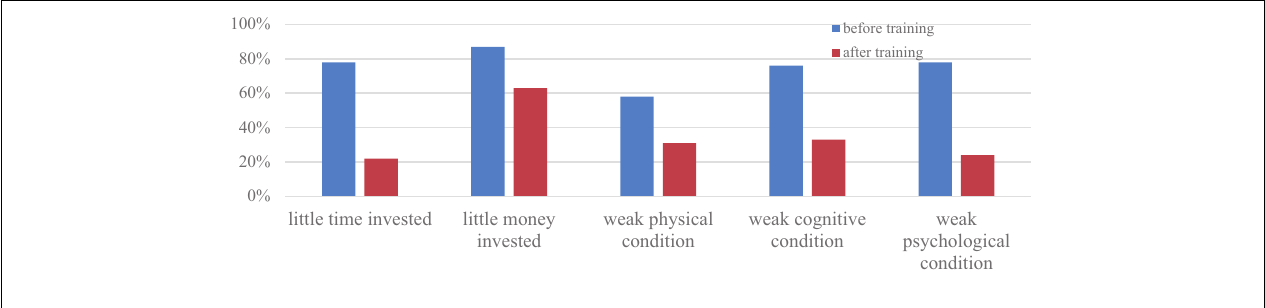
FIGURE 3 | Rural teachers’ engagement at work before and after taking the